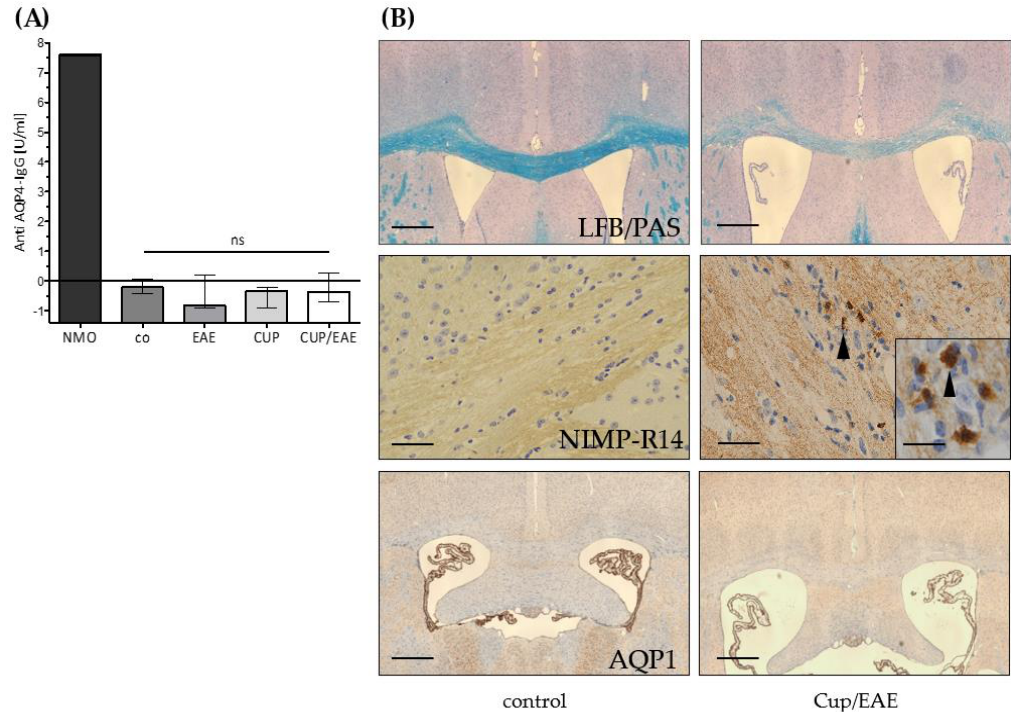
Figure 4. Anti AQP4-IgG serum levels. ( A ) Anti- AQP4 IgG levels in blood sera of the control group (co) and after EAE, cuprizone (CUP), or Cuprizone/EAE (CUP/EAE) induction. Neuromyelitis optica (NMO)-patient serum (provided by kit) was used as positive control. Commercial anti-mouse AQP4-antibody (sc20812) 1:50 diluted in PBS was tested positive with 45.34 U/mL (not shown). Data is shown as median + IQR and tested via Kruskal-Wallis test; co n = 5, CUP n = 5, EAE n = 10, CUP/EAE n = 10. ( B ) Representative images of control and Cup/EAE brain sections, processed for either LFB/PAS (top row), anti-NIMP-R14 immunohistochemistry (middle row), or anti-AQP1 immunohistochemistry (bottom row). Arrowheads in the middle row indicate granulocytes. Scales: top & bottom 180 µm; middle: 90 µm; insert 30 µm.